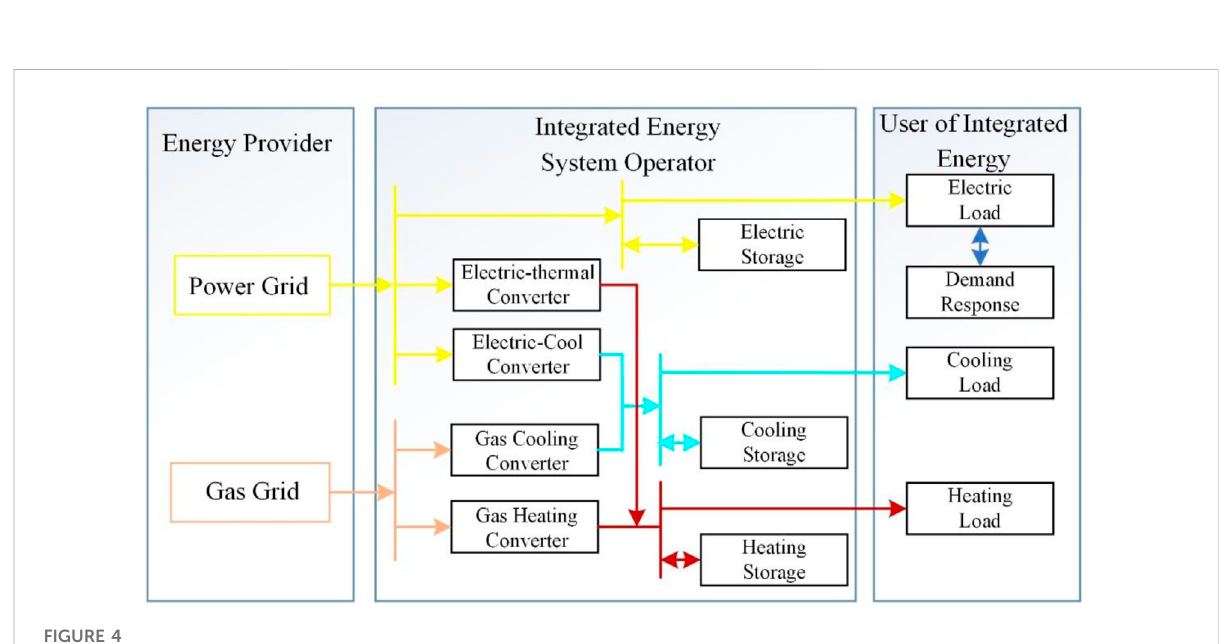
FIGURE 4 Structure of the test integrated energy